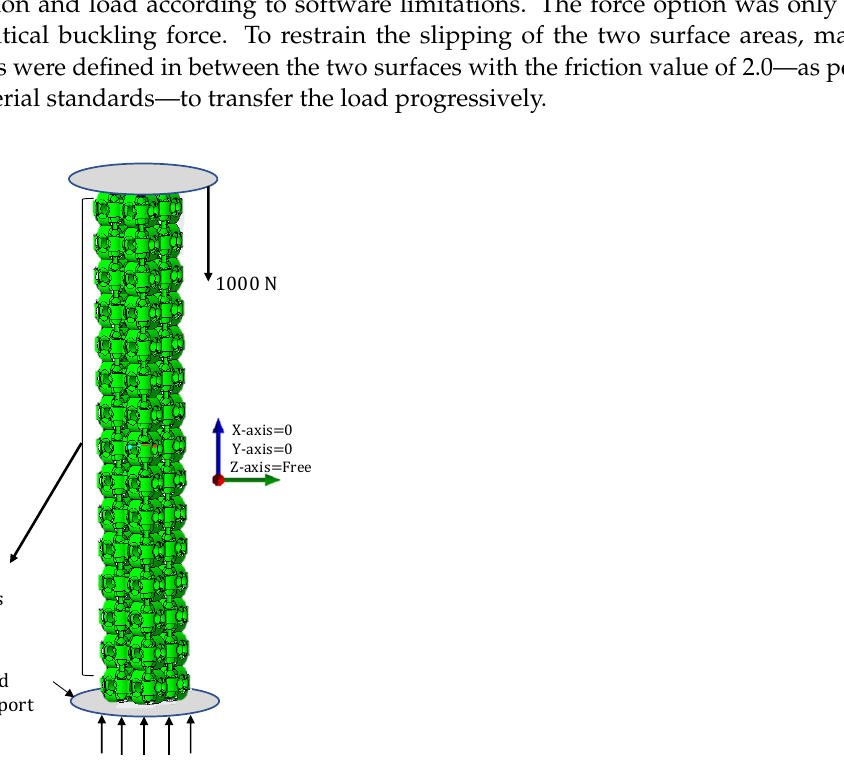
Figure 12. Numerical compression of the 2 × 2 × 15 structure with eigenvalue buckling analysis in ANSYS static